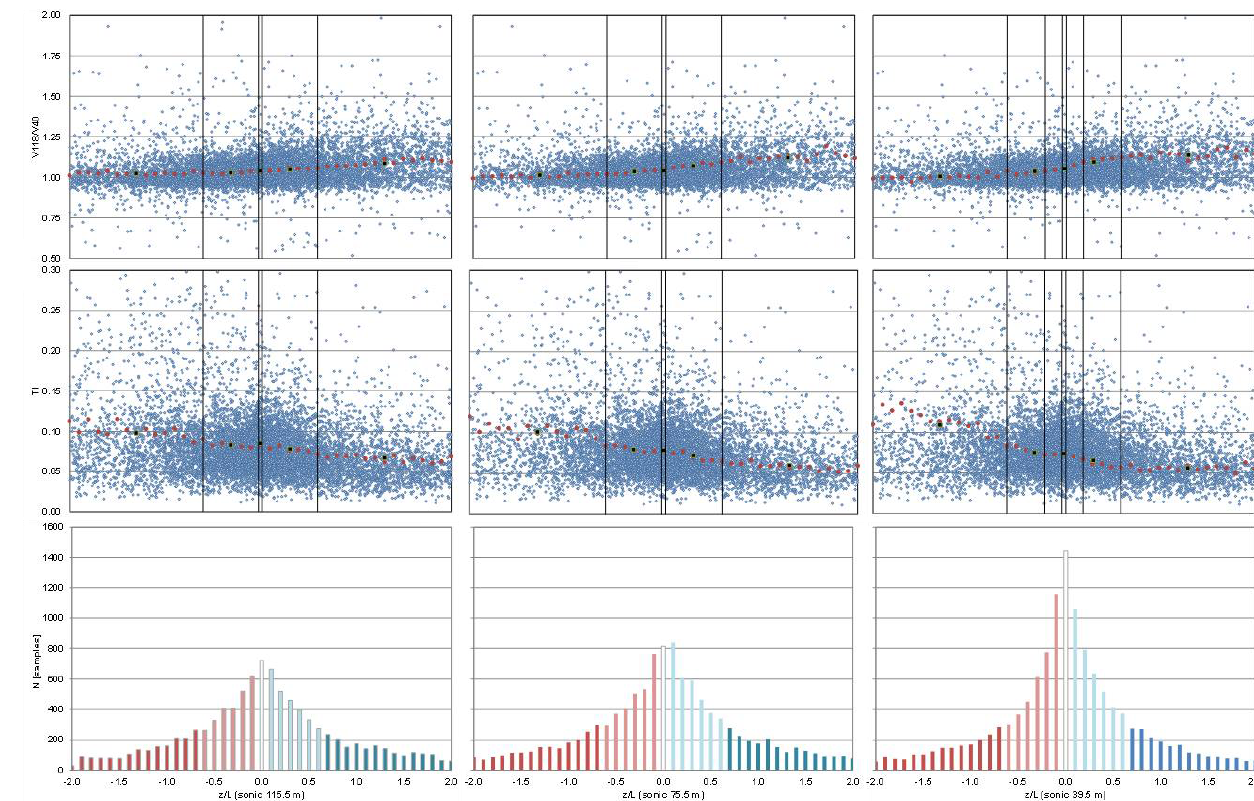
Figure 9. Wind shear and turbulence intensity vs. sonic stability in the MP5 337.5–22.5 ◦ sector. Red dots are the z/L mean values for 0.01 resolution scale, and black squares are the z/L mean values in each of the stability classes according to Table